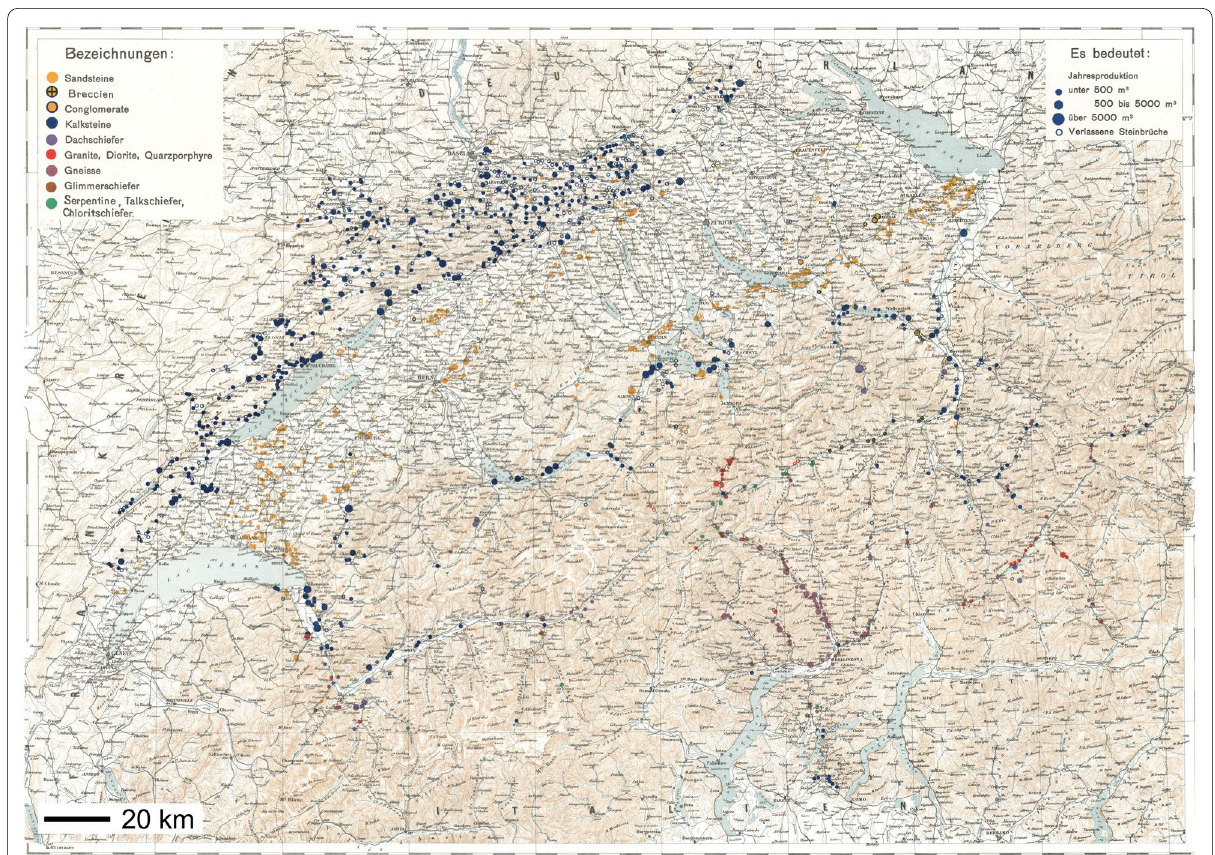
Fig. 7 Building stones quarries map (1:500 ′ 000) by Niggli et al. (1915). The map is shown in its full extent in order to get an overview of the areas that were explored the most. Details are not readable at that map scale. See the full resolution of this map in Additional file 2. Explanation of circle symbols colours: blue : limestones, yellow : sandstones, blue-grey : roof slates, red : granites, purple : gneisses, brown : mica schists, green : serpentinites & talcschists. The size of the circles represents the amount of extracted material. Empty circles highlight abandoned quarries. Note that limestones occur and were mined along both the Jura and the Helvetic Nappes of the Alps; sandstone quarries were located exclusively in the Molasse